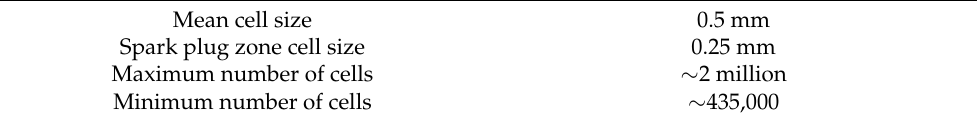
Table 4. Combustion mesh